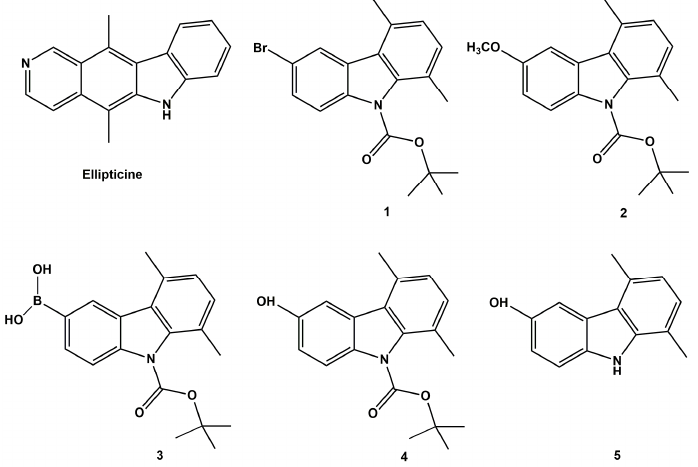
Figure 1. Structures of Ellipticine and the studied carbazole derivatives ( 1 – 5 ) previously synthesized by us [25].